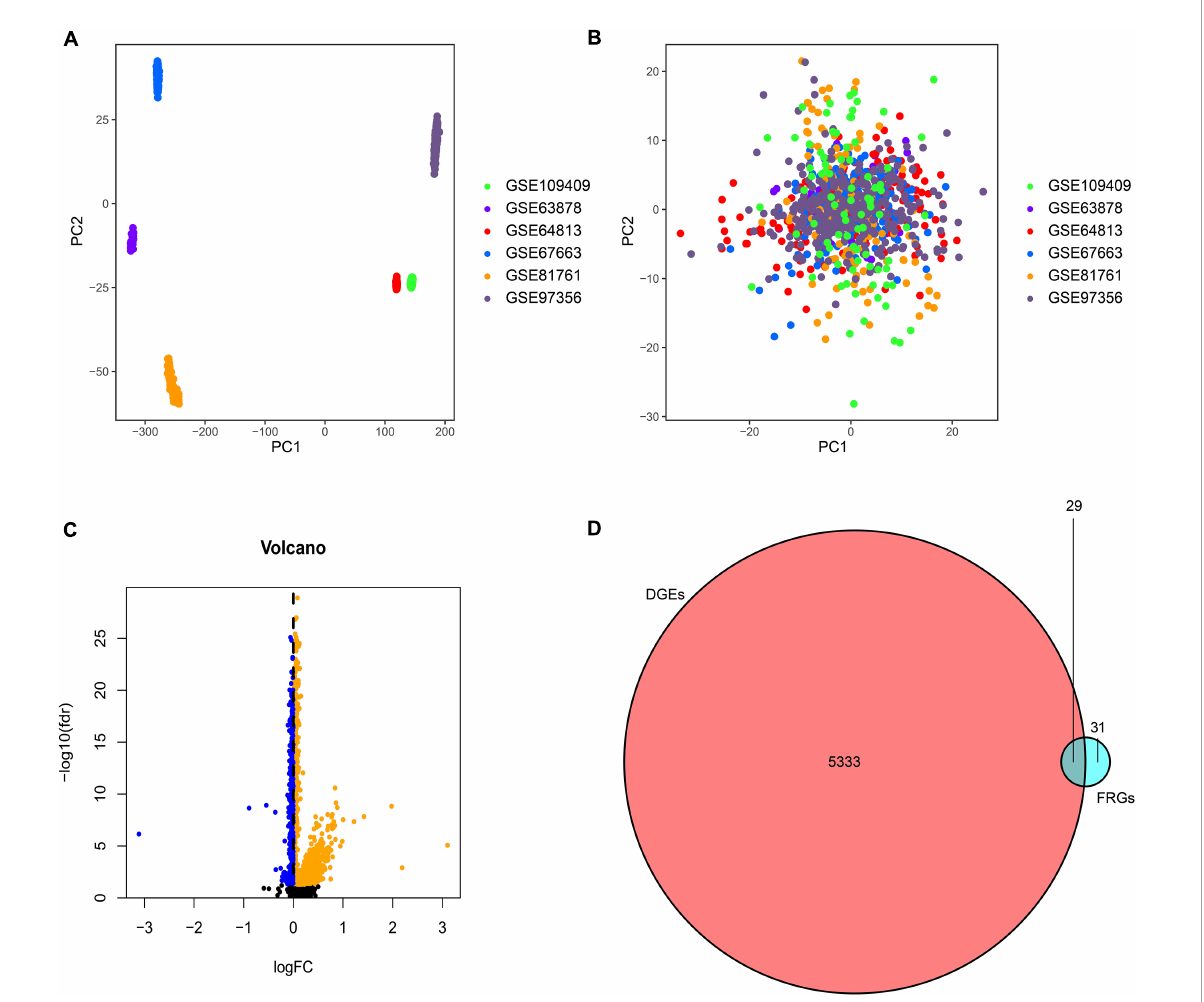
FIGURE2 Principal component analysis (PCA) of the six GEO datasets. (A) Scatter plots present the samples based on two principal components (PC1 and PC2) without removing the batch effect. (B) Scatter plots to present the samples with the removal of batch effect. (C) Volcano plot of DGEs in the combined GEO cohort. The orange spots represented the up-regulated genes, and the blue spots represented the down-regulated genes between PTSD and controls. (D) Venn diagram of DGEs and FRGs showed the cross-match gene set contained 29 crucial FRGs.